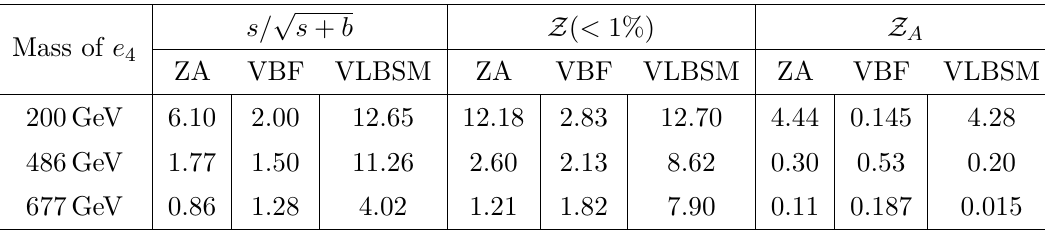
Table 8. Signal significance for an evolutive algorithm that maximizes Asimov significance metric. All significances are computed for L = 3000 fb − 1 .